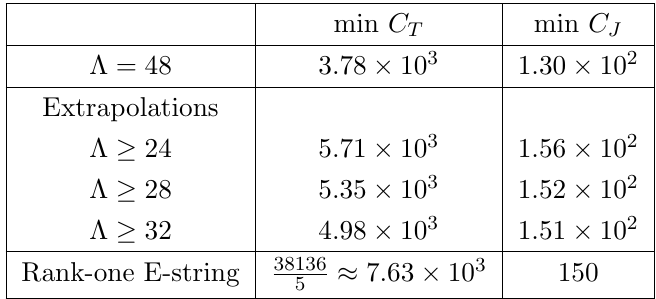
Table 2 . The lower bounds on C T and C J for interacting theories with E 8 (cid:13)avor symmetry. Presented are the bounds at the highest derivative order computed ((cid:3) = 48), as well as the extrap- olations to in(cid:12)nite (cid:3) using the quadratic ansatz (8.1).